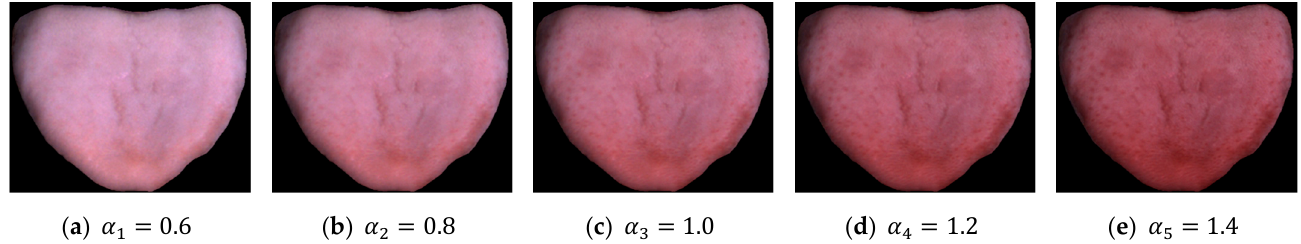
Figure 4. Five levels of color modulation using the modulation coefficient α